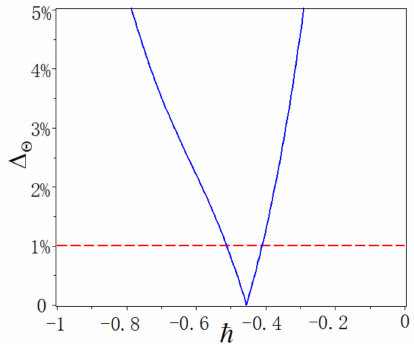
Figure 6. Relative errors curve ∆ Θ − ћ of original Equation (47) when α = 20, ε = 8/ π 2